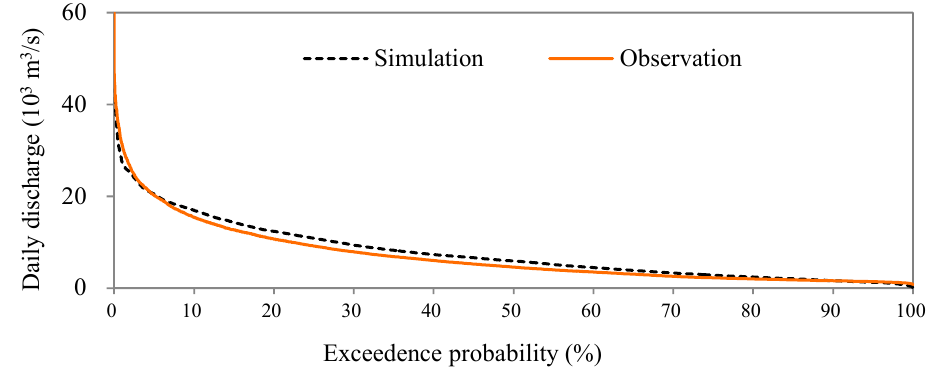
Figure 4. Flow duration curves of daily observed/simulated runoff through the Gaoyao hydrological station on the Xijiang River (1961–1990).